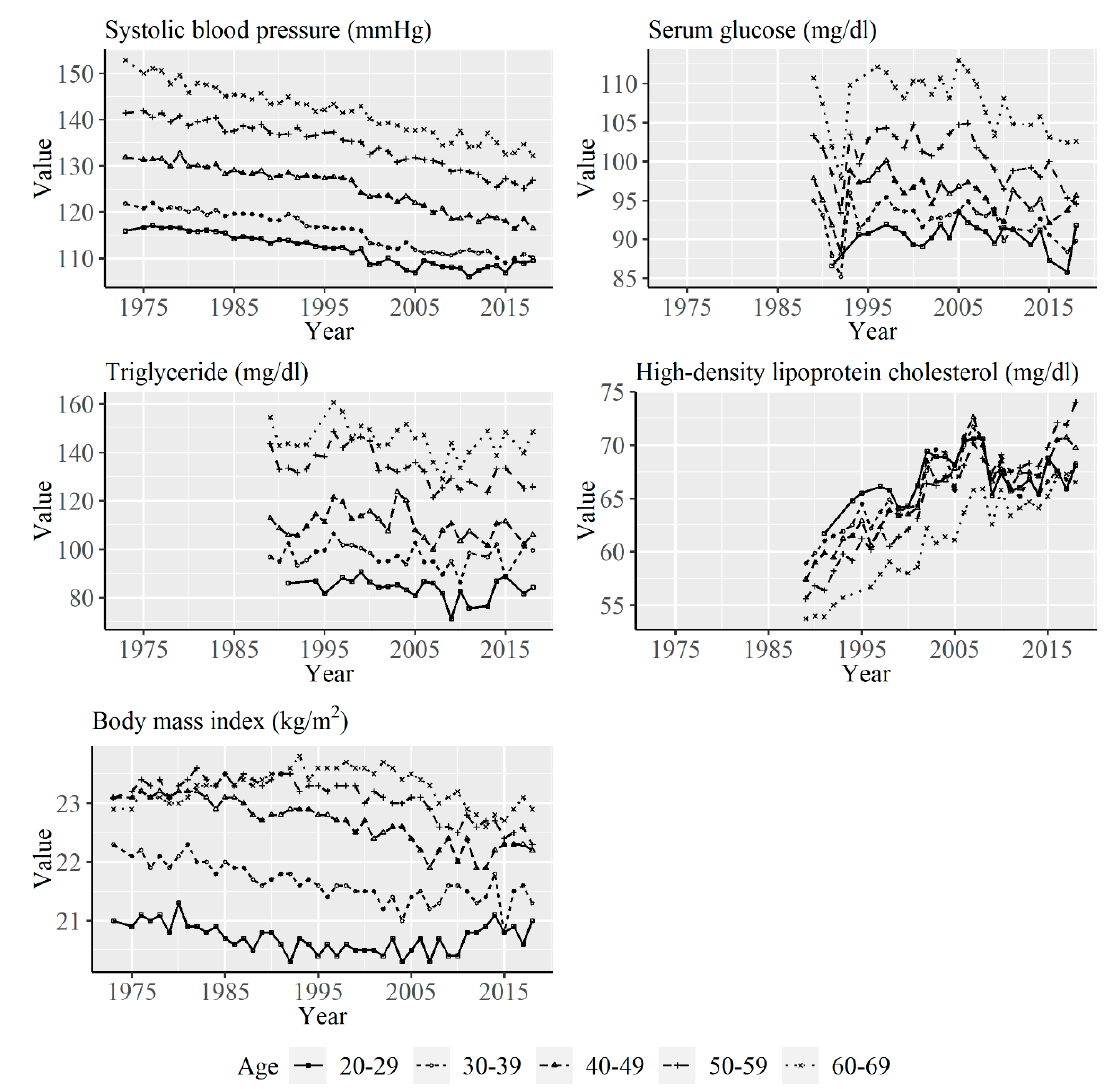
Figure 2. Yearly average values of systolic blood pressure, serum glucose, triglyceride, high-density lipoprotein cholesterol, and body mass index (BMI) according to age group among women from 1973 to 2017. Data on serum glucose, triglyceride, and high-density lipoprotein cholesterol were available from 1989.